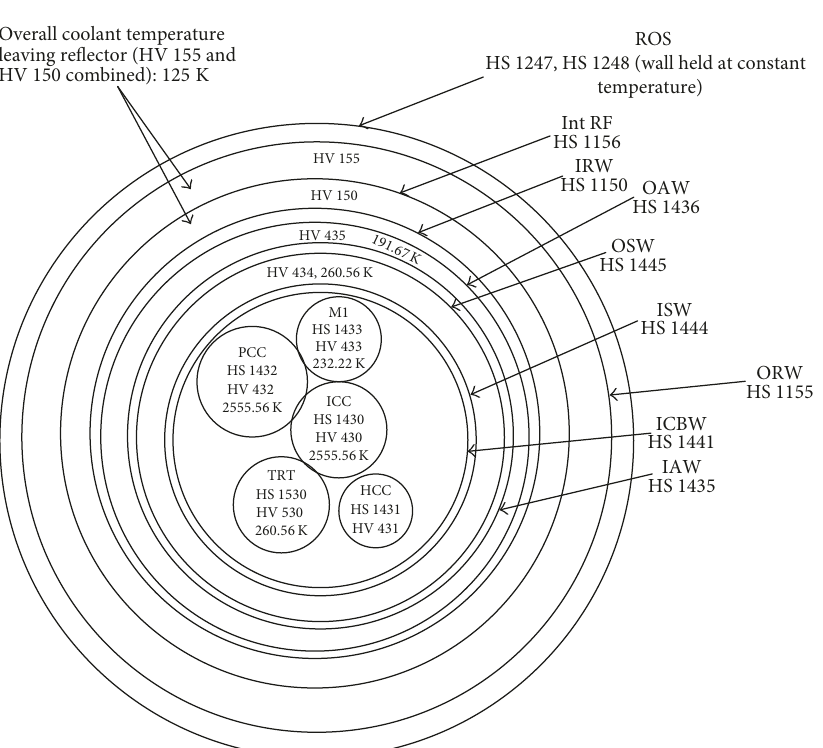
Figure 9: Pewee I radial nodalization diagram of core/reflector region. HS: heat structure; HV: hydrodynamic volume; M1: M1 elements; ICC: inner coolant channels; PCC: peripheral coolant channels; HCC: hot coolant channels; TRT: tie rod tubes; ICBW: inner core boundary wall; ISW: inner slat wall; OSW: outer slat wall; IAW: inner annulus wall; OAW: outer annulus wall; IRW: inner reflector wall; Int RW: intermediate reflector wall; ORW: outer reflector wall; ROS: rocket outer